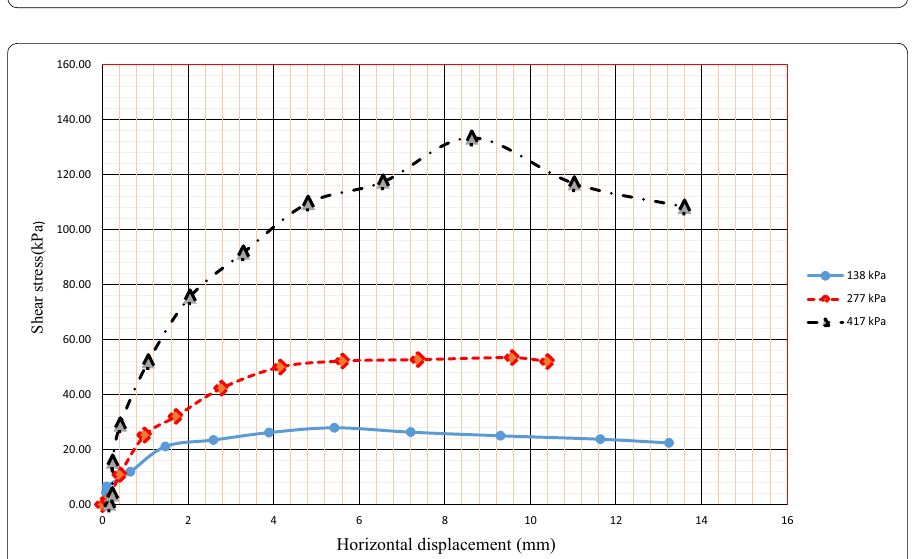
Fig. 3 Shear stress versus horizontal displacement curve for soil to soil test for specimens set